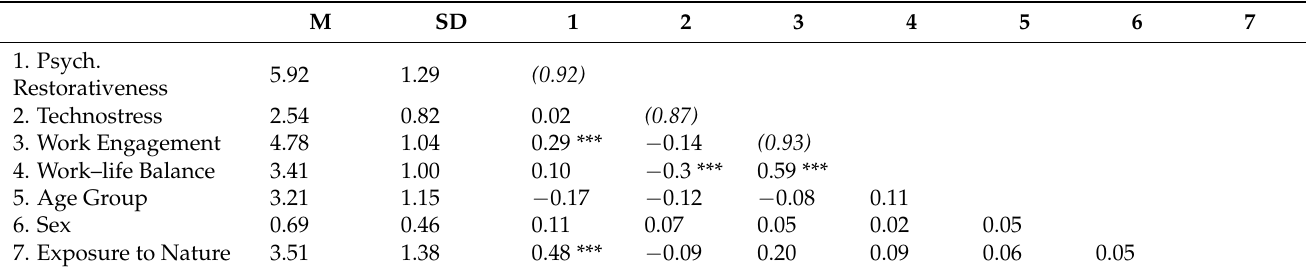
Table 3. Descriptive and correlation